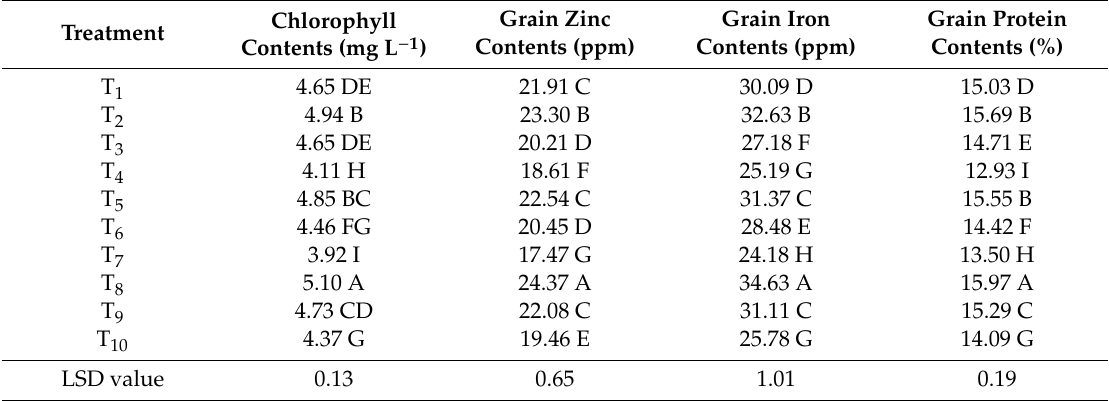
Table 5. Influence of di ff erent vermicompost treatments on the biochemical attributes of wheat.